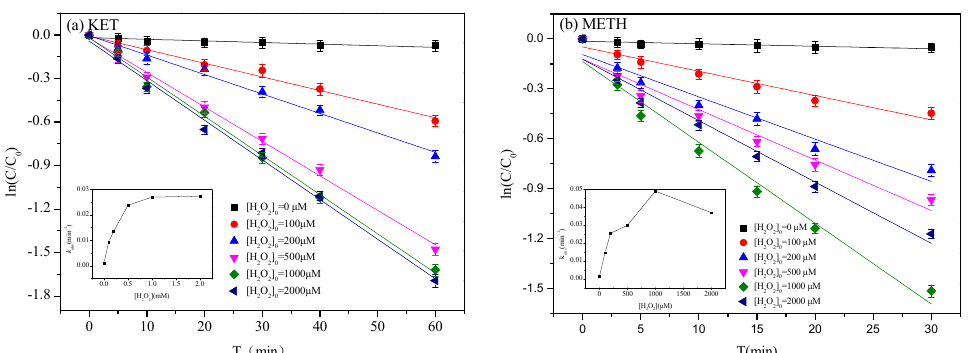
Figure 5. Effect of H 2 O 2 dosage on KET ( a ) and METH ( b ) degradation in the UV/H 2 O 2 system. Conditions: (KET) 0 = (METH) 0 = 100 µ g / L, (H 2 O 2 ) 0 = 0–2000 µ M, pH 0 = 7.0, T = 25 ± 1 ◦ C. Conditions: (KET) 0 = (METH) 0 = 100 μg/L, (H 2 O 2 ) 0 = 0–2000 μM, pH 0 = 7.0, T = 25 ± 1 °C.